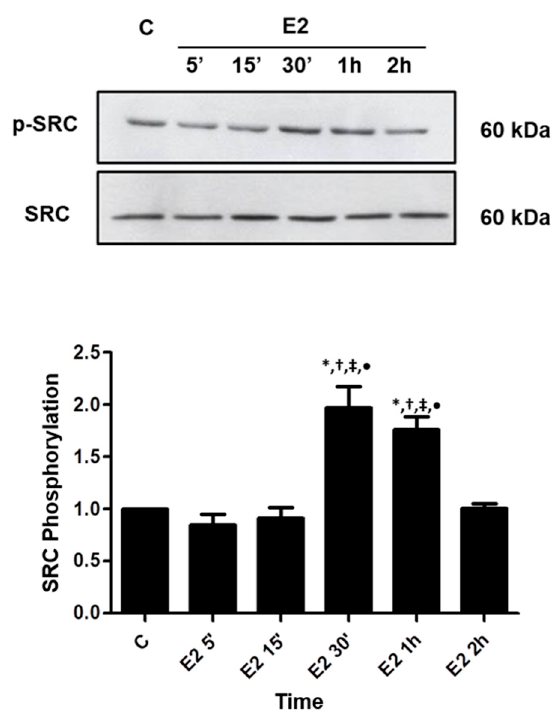
Figure 1. Effects of 17 β -estradiol (E2) on SRC (Tyr419) phosphorylation in androgen-independent prostate cancer cells PC-3. The cells were incubated in the absence (C, control) and presence of E2 (10 nM) for 5, 15, 30 min, 1 and 2 h at 37 ◦ C. Phosphorylated SRC (p-SRC) and total SRC were detected by Western Blot. The immunoassay was performed with anti-phosphorylated SRC (upper panel) and anti-total SRC antibodies (lower panel). The relative position of SRC was determined from the molecular weight standard. The data shown are representative of three independent experiments. Densitometric analysis was performed of the results obtained from each band, normalized by the expression of the total SRC and expressed in relation to the control (C = 1). Results were plotted (mean ± SEM) of three independent experiments. * Significantly different from the values obtained in relation to the control (C) ( p < 0.05, ANOVA and Newman-Keuls). † Significantly different from E2 5 min ( p < 0.05, ANOVA and Newman-Keuls). ‡ Significantly different from E2 15 min ( p < 0.05, ANOVA and Newman-Keuls). • Significantly different from E2 2 h ( p < 0.05, ANOVA and